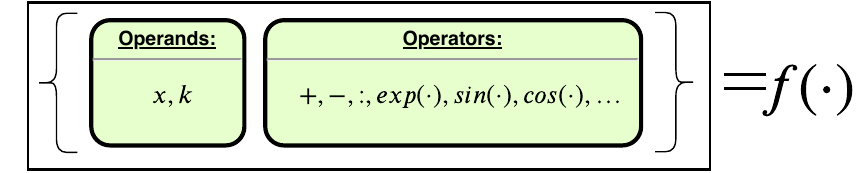
Figure 3. Representation of genetic programming (GP)-based symbolic regression; y = laundry moisture content during the drying cycle, x = independent variables (signals available), and k =